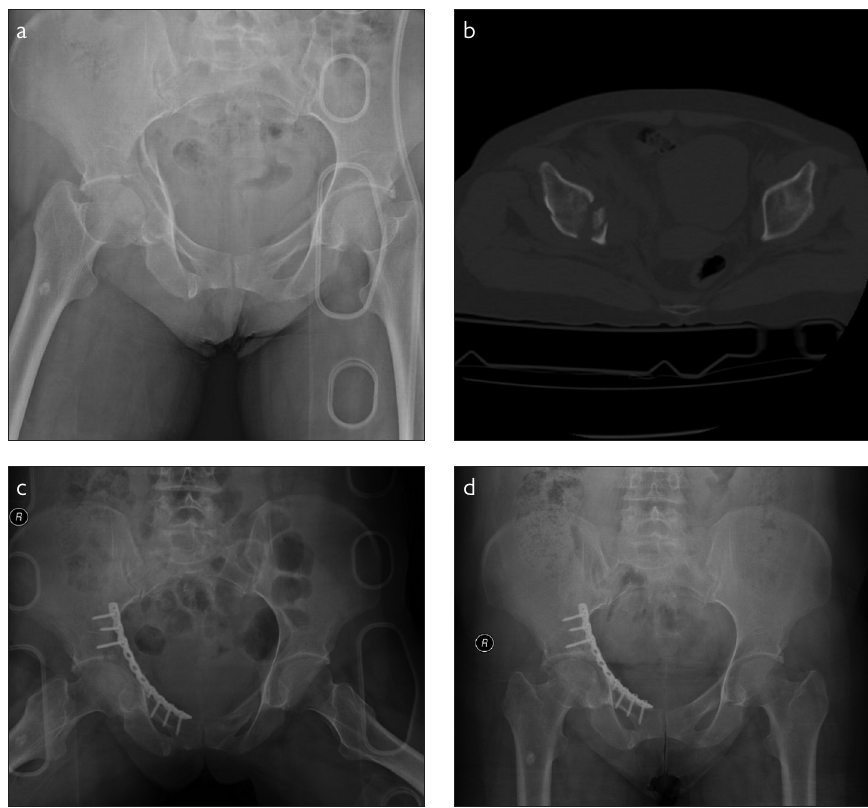
Figure 3. a-d. T-shape fracture after a traffic accident was present in a 58-year-old woman. The patient was operated on the 6th day after trauma with a modified Stoppa approach. Postoperative x-rays were assessed as a successful reduction (c). The outcome was assessed as radiologically and functionally perfect at 18th-month follow-up. X-ray and CT sections; a) preoperative pelvis ap, b) preoperative axial